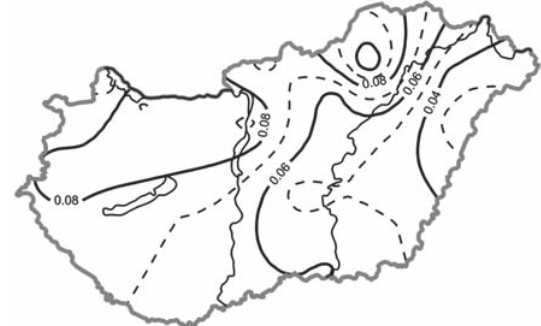
Figure 8 – The spatial distribution of slopes of the trend function of absolute temperature minima in winter measured at 16 stations over a period of